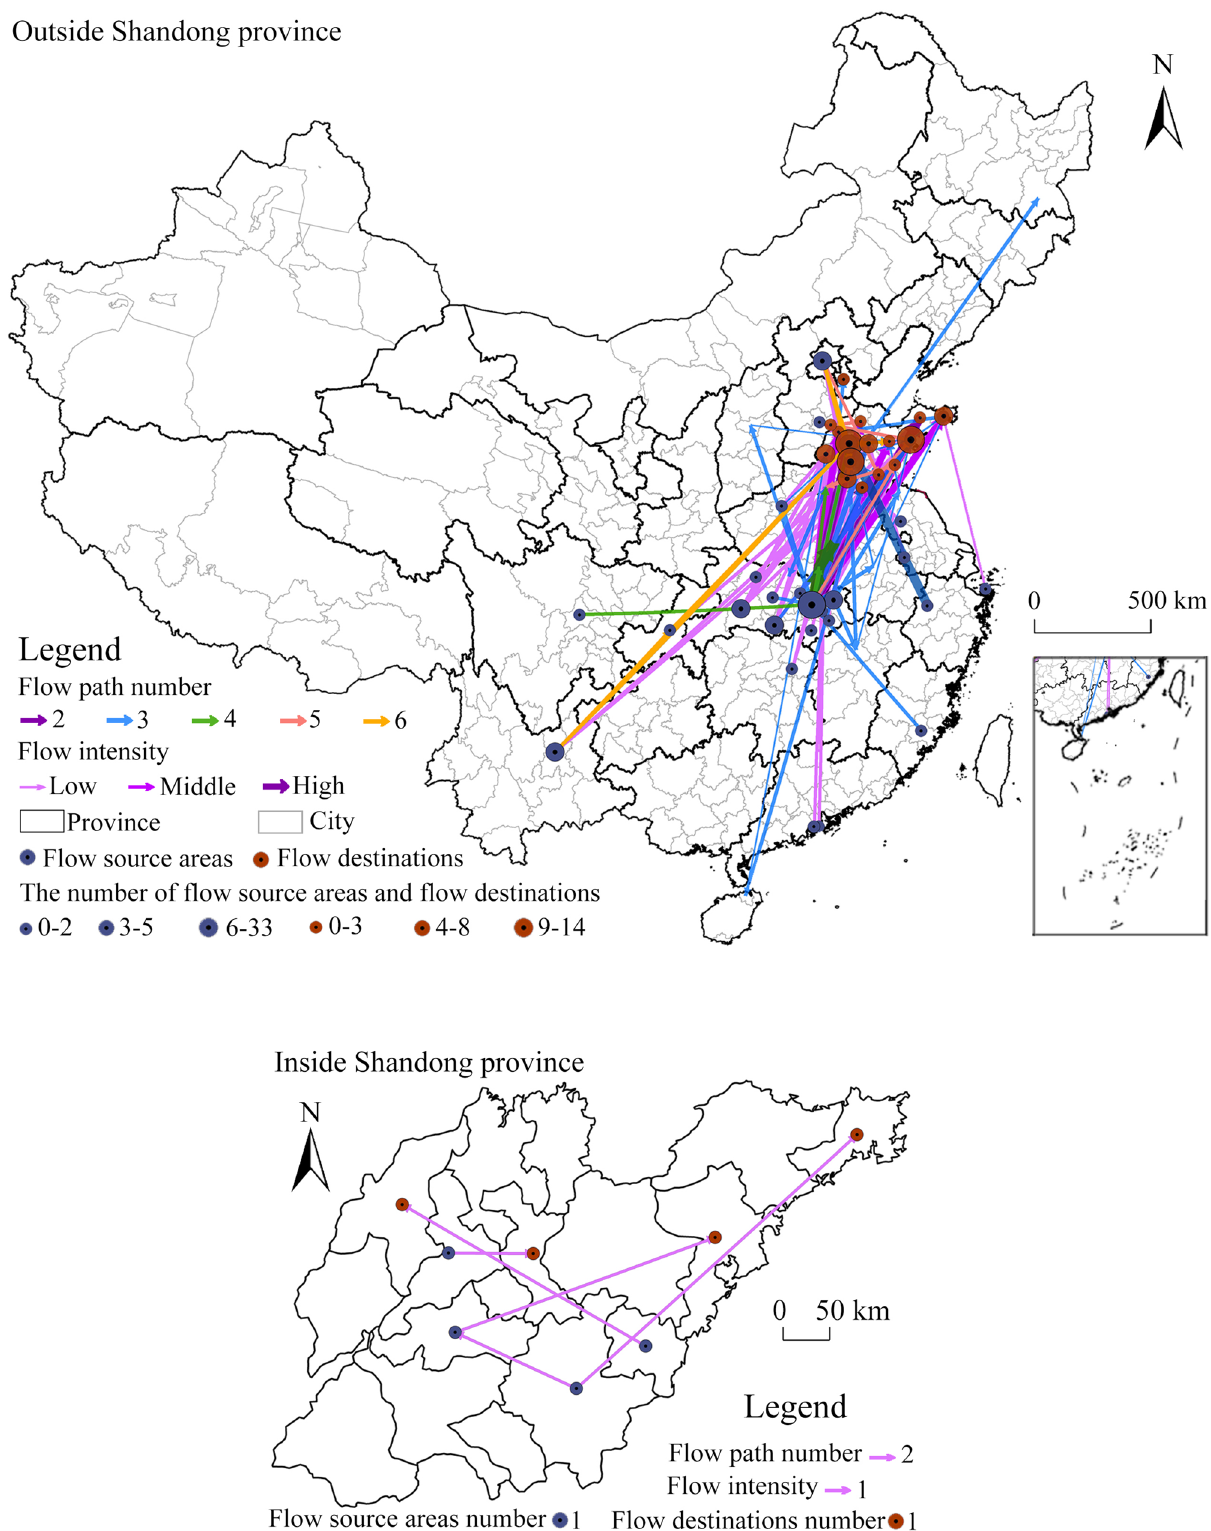
Figure 12. Spatial flow paths of confirmed COVID-19 cases in Shandong province (this graph is produced by using ArcGIS10.3. http:// www. esri. com; The base map is from China Standard Map Service. http:// bzdt. ch. mnr. gov.